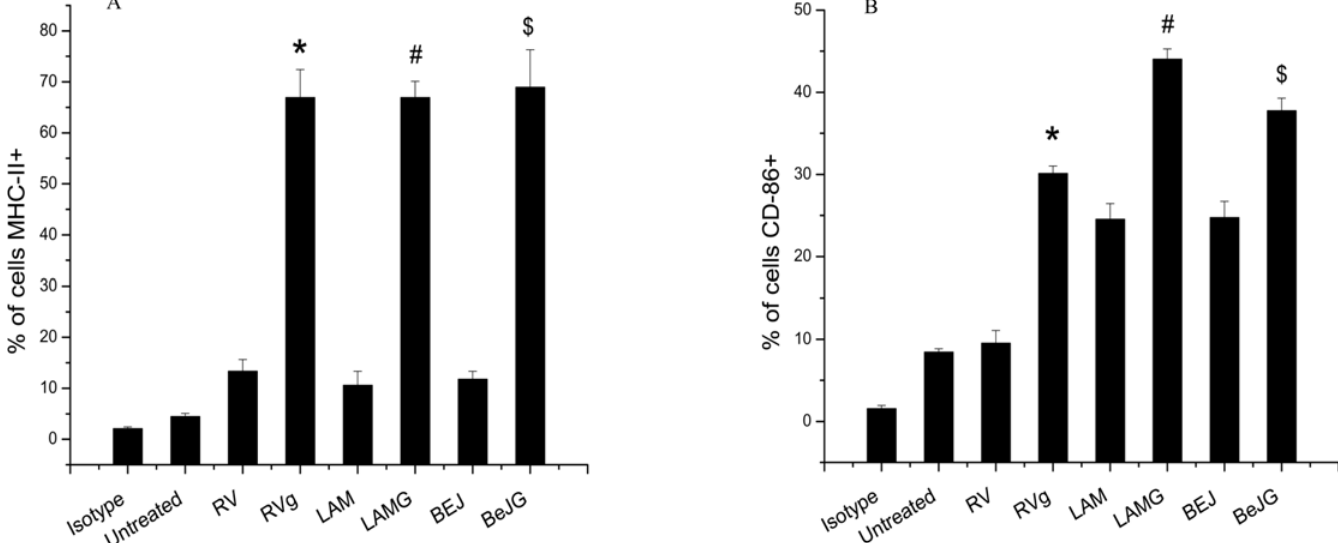
Fig 3. Effect of G1-4A on CD-86 and MHC-II expression in MTB infected RAW cells. RAW cells were treated with G1-4A and infected with three strains of MTB. Post G1-4A treatment cells were incubated with FITC I-A d , FITC anti – CD86 and FITC IgG2a and surface expression was evaluated by flow cytometry. (A) and (B) are quantitative representation of percentage of cells MHC-II+ and CD-86+ ( * p < 0.01 as compared to untreated H37Rv infected control, #p < 0.01 compared to untreated LAM infected control and $p < 0.01 compared to Beijing infected control, values of at least three independent experiments presented as Mean ±